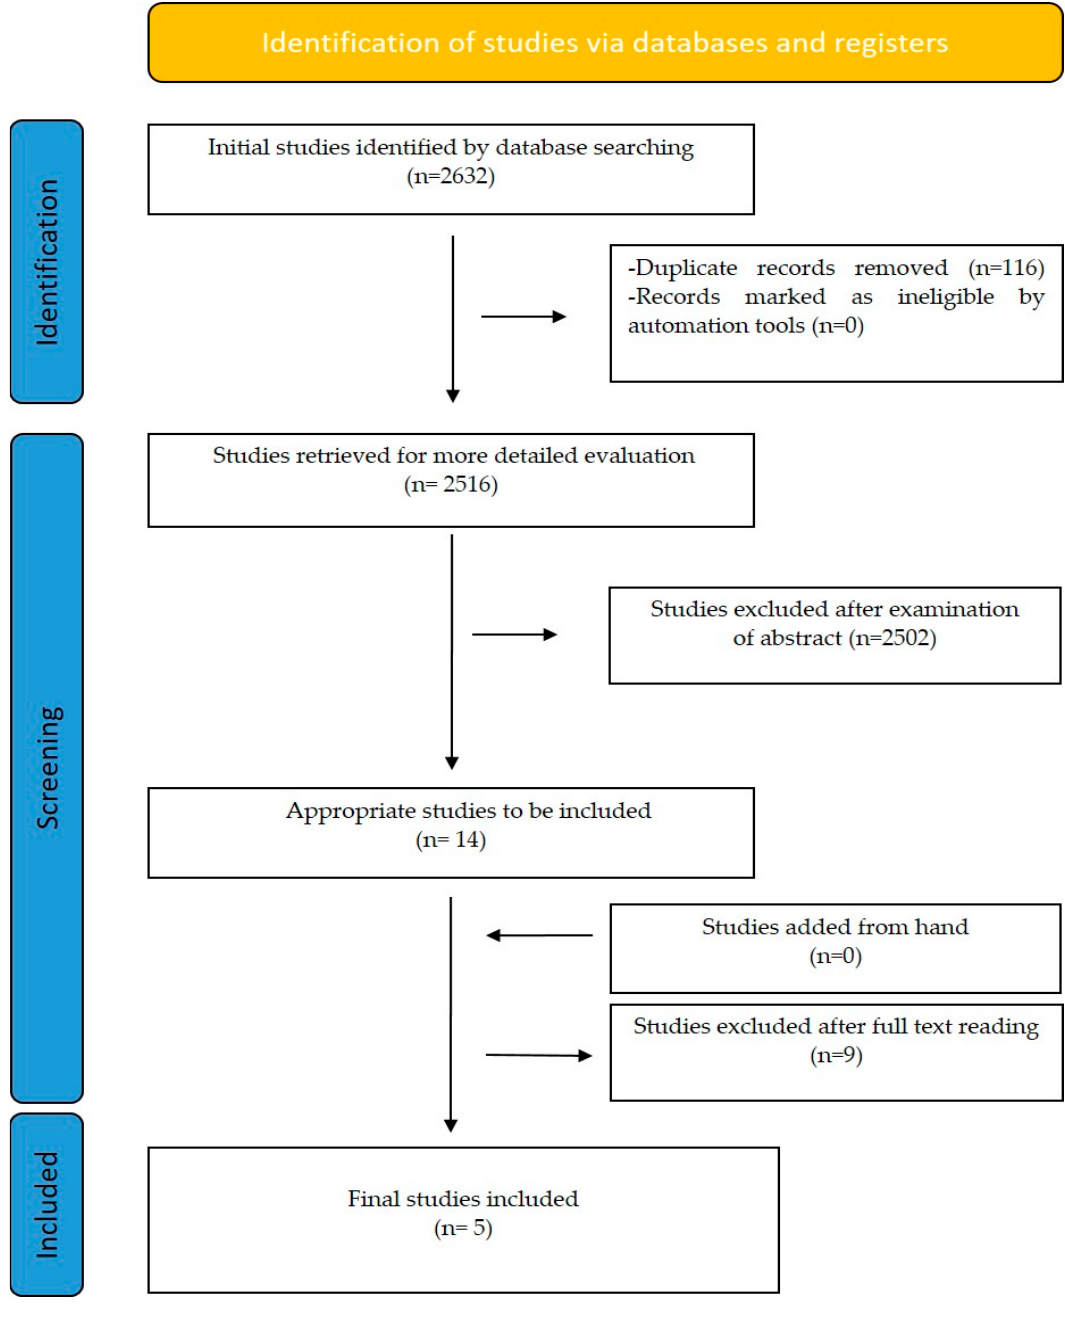
Figure 1. Prisma flow chart selection of records.